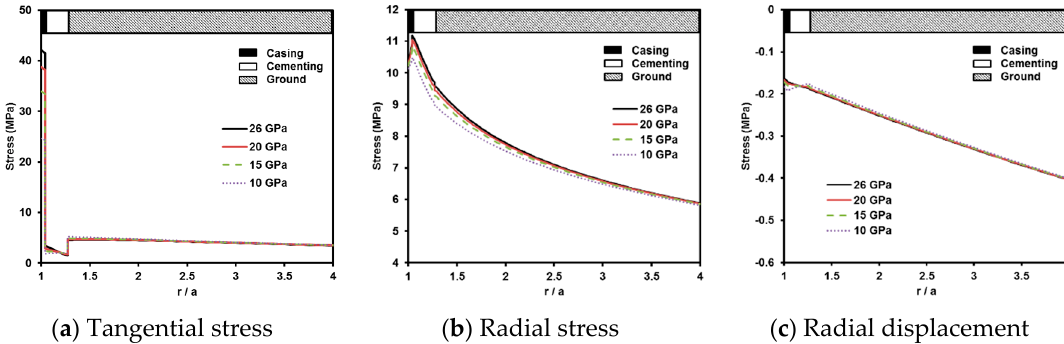
Figure 11. Stress and displacement at 2500 m with variation of Young’s modulus of the cementing component.